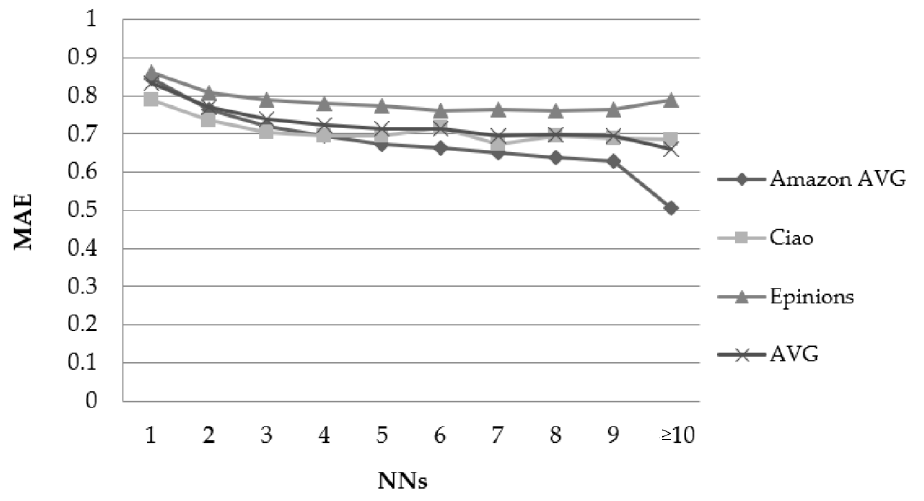
Figure 1. Effect of the number of NNs features in the rating prediction MAE when using the PCC user similarity metric. user similarity